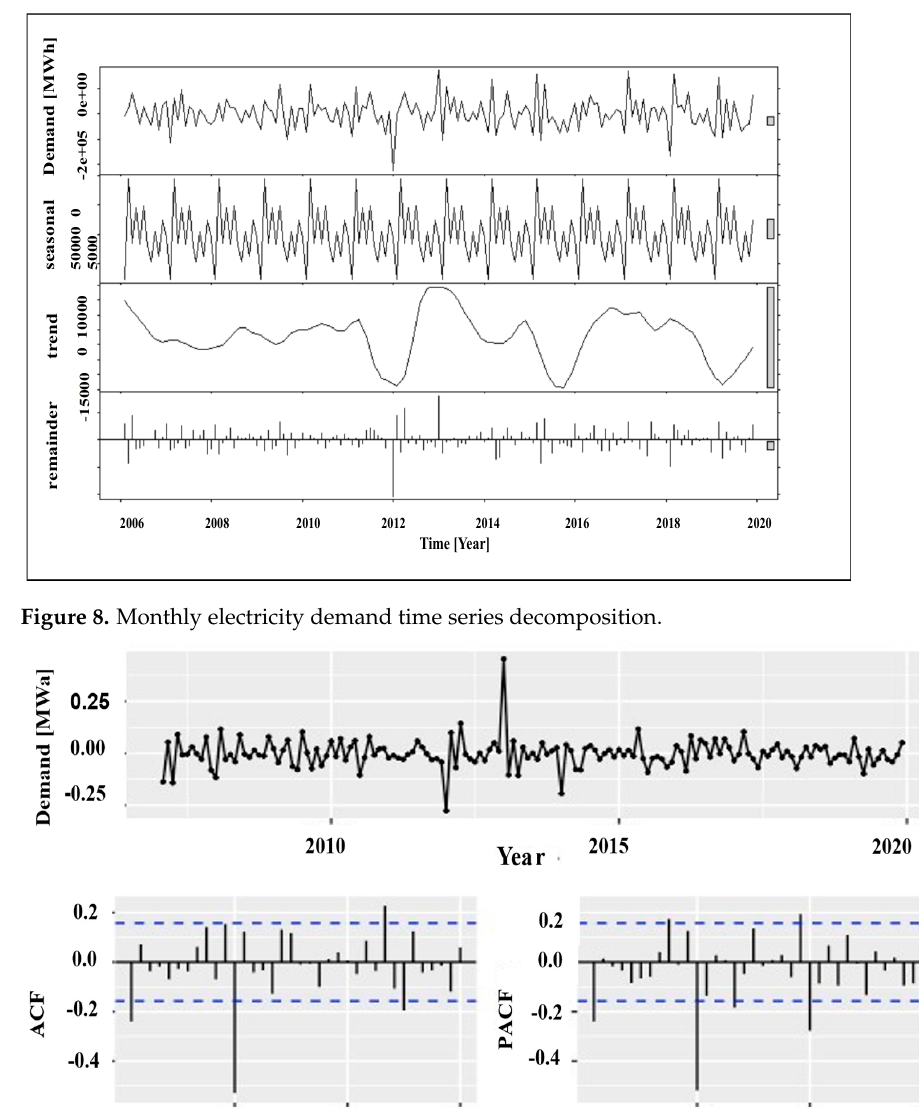
Figure 9. ACF and PACF plots of seasonal and non-seasonal differenced